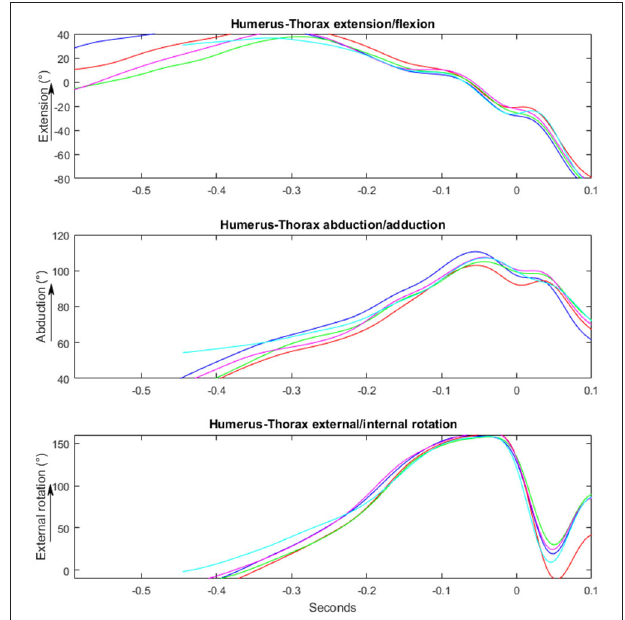
FIGURE 4 | Illustrating a kinematic movement of a standing overhead throw performed by a player playing with no pain. Y-axis shows the changes in degrees/ ◦ . X-axis shows the time in milliseconds, where 0 is the time of ball-release.